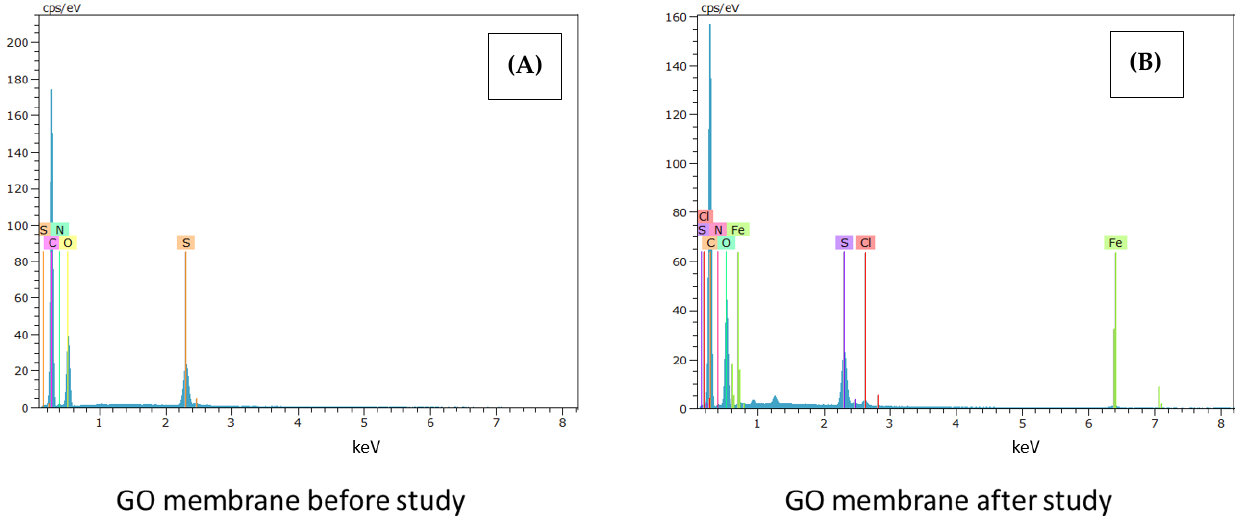
Figure 4. SEM-EDX spectra corresponding to the membrane modified with graphene oxide ( A ) before and ( B ) after the experiments.